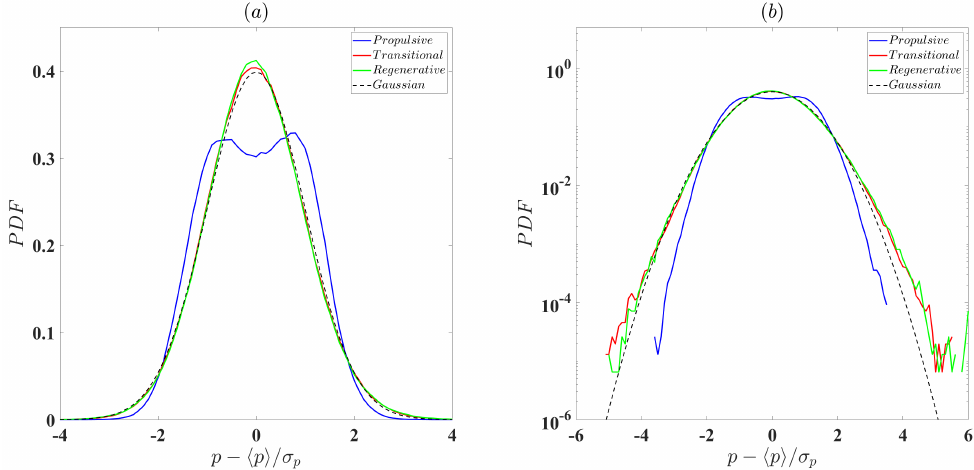
Figure 8. Probability density function of the near field pressure signals for each operational condition. The PDFs are reported in both linear ( a ) and logarithmic scales ( b